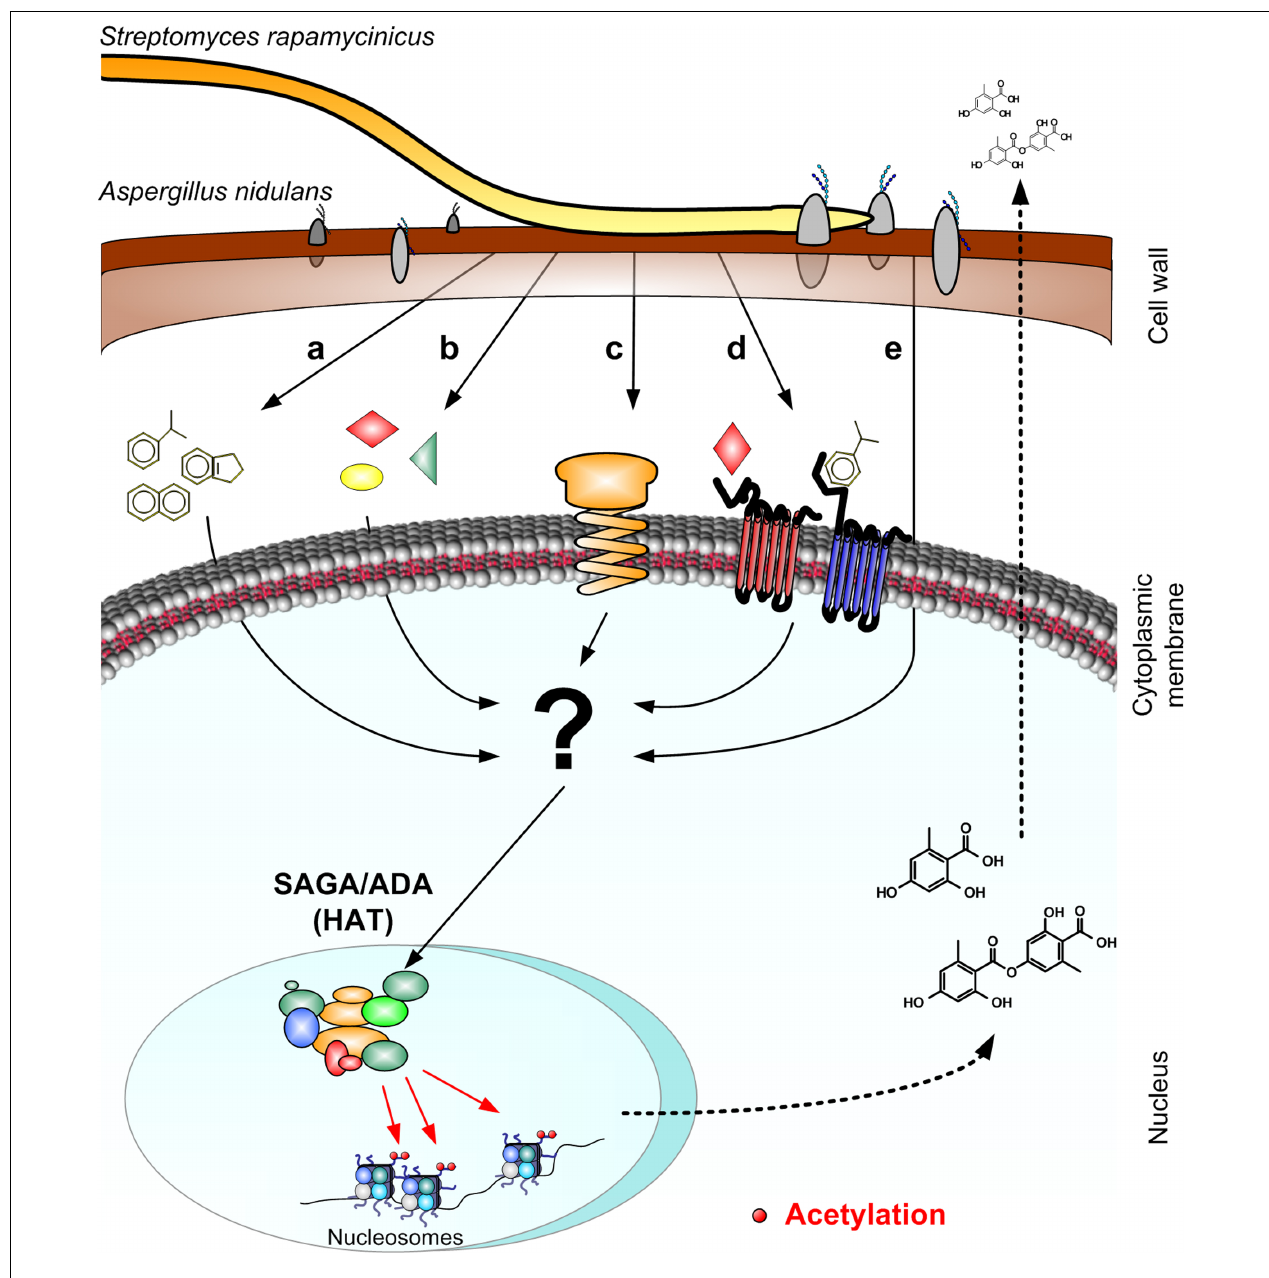
FIGURE 2 | Model of the interaction between A. nidulans and S. rapamycinicus . The figure presents hypotheses about different stimuli that could be responsible for the activation of SM gene clusters during the interaction between A. nidulans and S. rapamycinicus . The signal that finally results in the Saga/Ada complex activation could derive from at least five possible events: possibly membrane-bound compounds (a), or peptides (b),